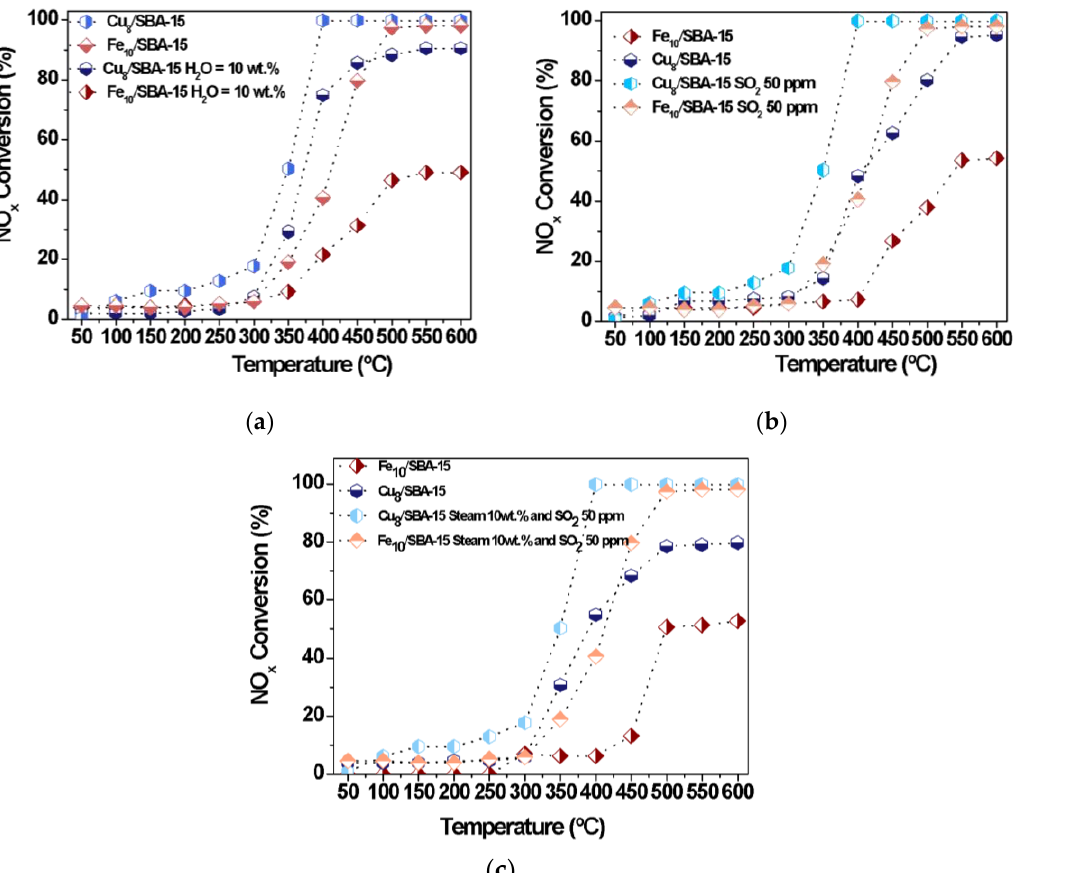
Figure 9. NO x conversions as a function of the temperature in the presence of distinct poisons ( a ) Steam 10 wt.%, ( b ) SO 2 50 ppm and ( c ) both steam 10 wt.% and SO 2 50 ppm.